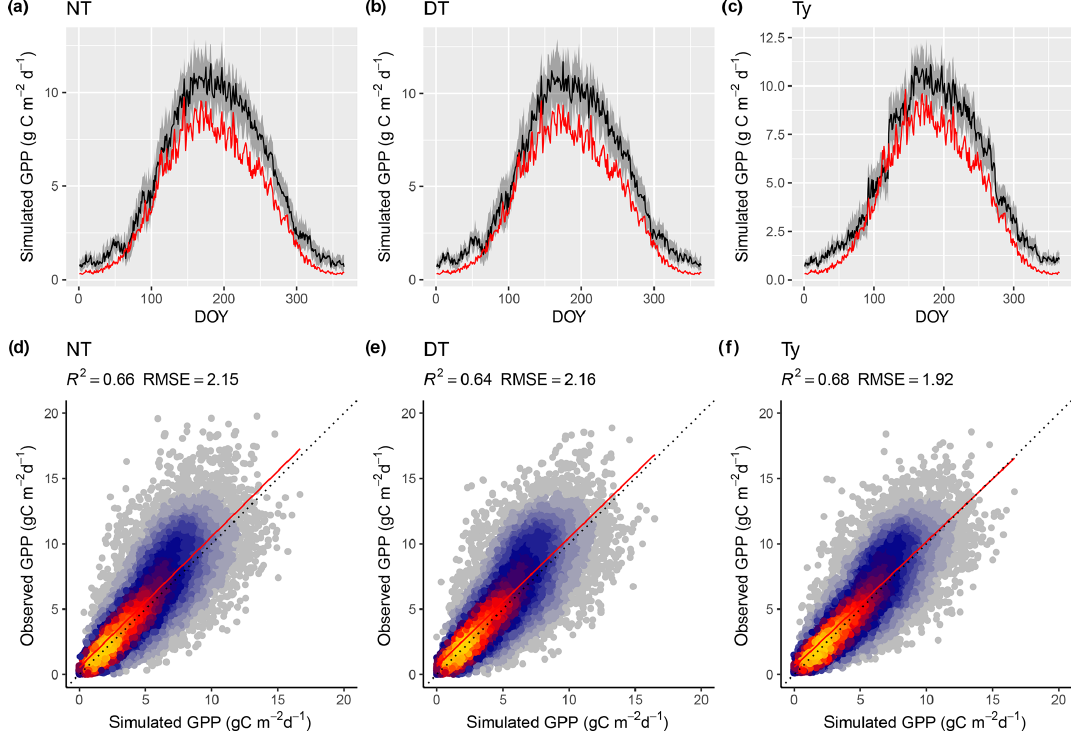
Figure 8. Model performance subject to comparison with different flux decomposition methods for GPP. (a–c) Mean seasonal cycle of simulated (red) and observed GPP (black) based on different flux decomposition methods for sites in climate zone Cfb north. The grey band represents the 33%/66% quantiles of observed GPP by DOY. (d–f) Correlation of observed and simulated GPP values of all sites pooled, mean over 8d periods, all sites pooled. “Observed GPP” refers to the different flux decomposition methods: DT for the daytime method (FULL_DT setup), NT for the nighttime method (FULL_NTsub setup), and Ty (FULL_Ty setup) for the method applied for data used in Wang et al. (2017b). Dotted lines in panels (d–f) represent the 1 : 1 relationship; red lines represent the fitted linear